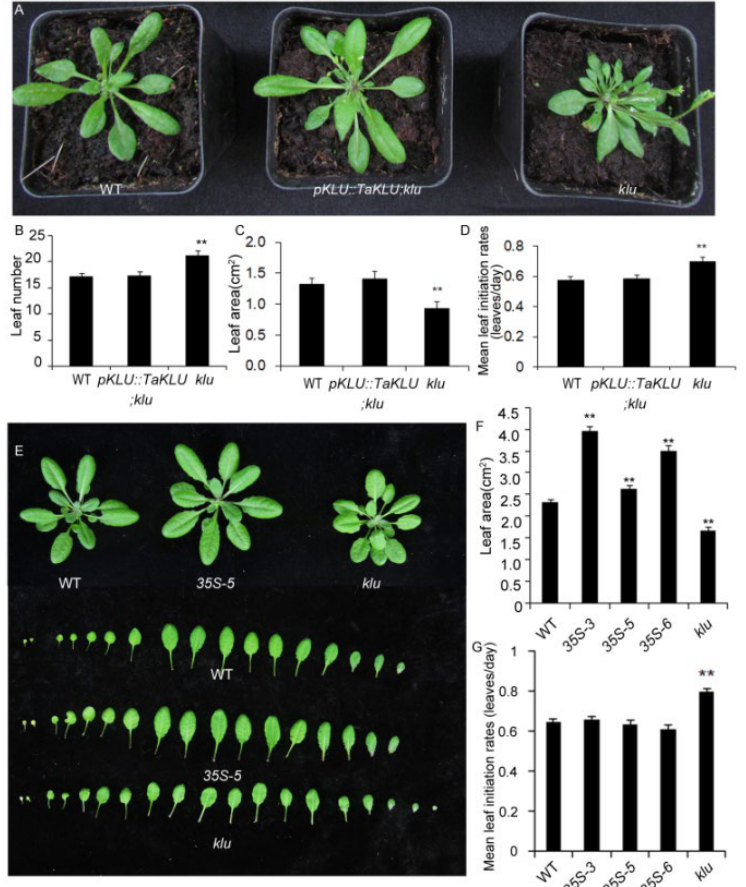
Figure 4. Conserved function of TaKLU and AtKLU in regulating organ growth. ( A ) TaKLU rescued the multi-leaf phenotype of klu mutants at 30 days after germination. ( B – D ) Quantification of rosette leaf number ( B ), n > 10), area ( C ), n > 5) and leaf initiation rates ( D ), n > 22) in the indicated genotypes at 30 days after germination. ( E – G ) Comparison of the leaf morphological characteristics between WT, 35S::TaKLU ( 35S-5 ) and klu mutant plants at 30 days after germination in Arabidopsis . ( E ) The seedling leaves of the indicated genotypes. ( F – G ) Statistics on the leaf area ( F ), ( n > 21) and leaf initiation rate ( G ), ( n > 13) of WT, 35S::TaKLU and klu mutant plants. Bars indicate SE. Asterisks (**) indicate significant differences from their WT at p < 0.01 ( t -test).